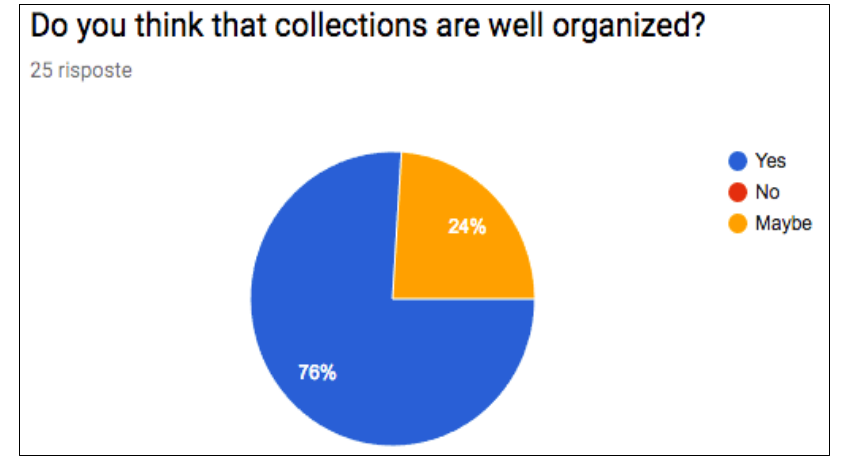
Figure 19. Opinion on the organization of documents